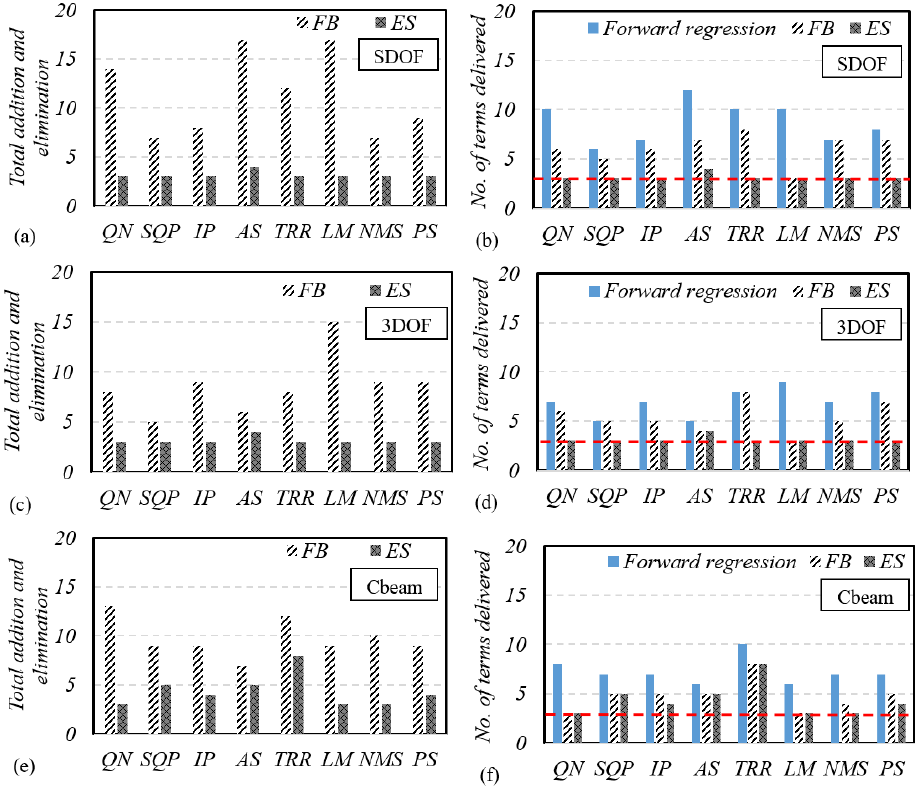
Figure 6. Evaluation of the number of terms processed by model selection algorithm using different optimisation methods ( a ) SDOF terms added and removed, ( b ) SDOF number of terms delivered, ( c ) 3DOF terms added and removed, ( d ) 3DOF number of terms delivered, ( e ) Cbeam terms added and removed, ( f ) Cbeam number of terms delivered; (The red dashed lines present the true number of the